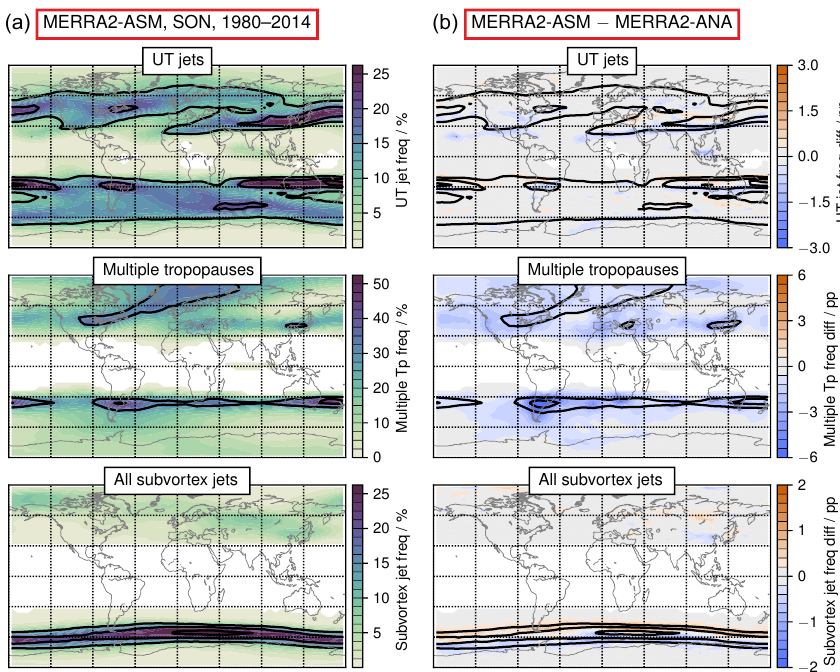
Figure 1. Seasonal maps for SON in 1980 through 2014 of MERRA-2 frequency distributions from ASM (see text) fields and the difference between ASM and ANA (see text). The rows show (top to bottom) the upper tropospheric jet frequency, multiple tropopause (Tp) frequency, and frequency of subvortex jets. Overlaid contours highlight the ASM distributions on the left ( a , ASM plots) and ANA distributions on the right ( b , difference plots). Frequencies are normalized as described in Sect. 2.3. Overlaid contours show frequency values from each reanalysis of 10, 20, and 30% for upper tropospheric and subvortex jets and 30, 45, and 60% for multiple tropopauses; the smallest value is always the largest or “outermost” contour. In the difference plots, blues/oranges indicate negative/positive differences. In this and all following figures, frequency distributions are expressed in percent (%) and arithmetic differences of frequency distributions in percentage points